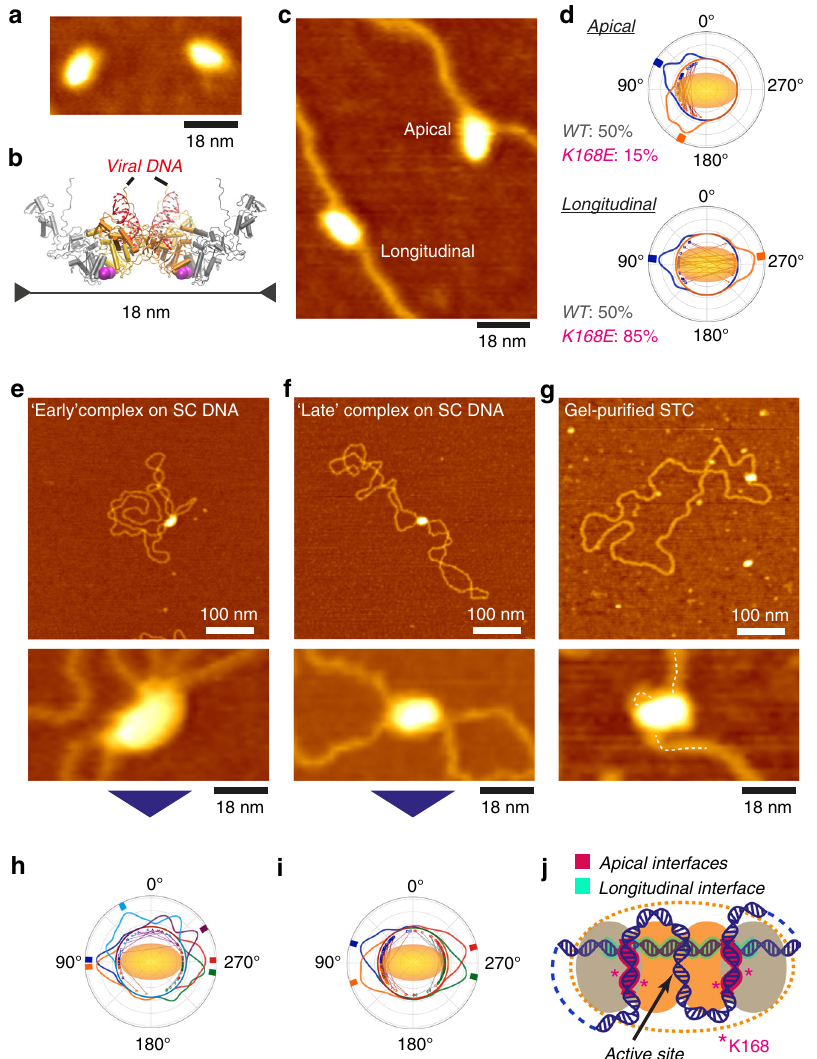
Fig. 2 Auxiliary DNA-binding interfaces are engaged in TCCs and STCs. a AFM images of CI intasomes. b Atomistic model of PFV intasome solution structure ( 21 ). Purple spheres indicate residues K168. Viral DNA mimetics (red) are not visible in our AFM data. c Early TCCs formed on linear pBR322 DNA reveal longitudinal and apical binding geometries. d Polar plots of entry and exit angles with respect to the intasome long axis for apical and longitudinal binding modes, and relative occurrence in WT and K168E intasomes. e AFM image of intasomes incubated brie fl y (2 min) with supercoiled plasmid DNA, depicting a branched complex as found in ~50% of early complexes. f AFM image of a bridging complex that dominates (~80%) the population of complexes at longer (>45 min) incubation. g AFM image of a gel-puri fi ed STC. h Polar plot of exit angles in branched complexes. i Polar plot of exit angles in bridging complexes. j Model for target DNA (blue) folding in TCC and STC intasomes (yellow dotted contour). Viral DNA mimetics are not shown. Source data are provided as a Source Data fi